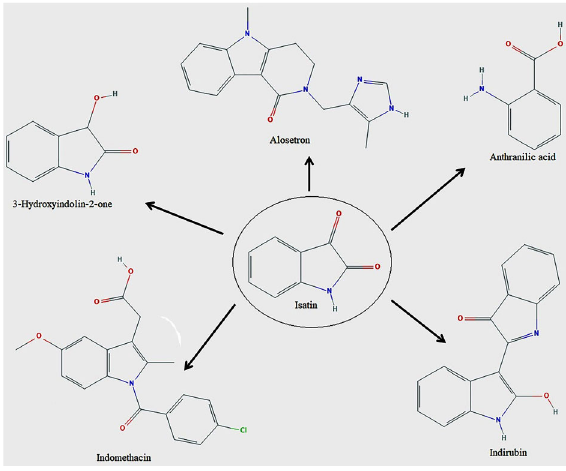
Figure 1. Examples of isatin moiety in drugs.